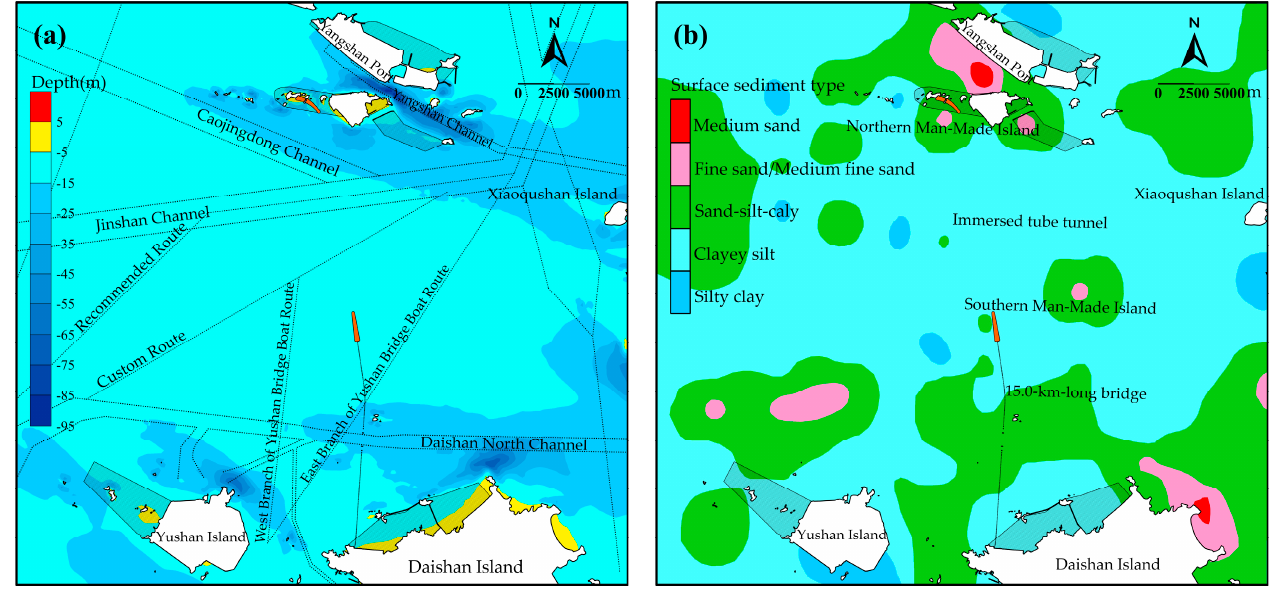
Figure 2. Distribution of present navigation channels and seabed sediment pa tt erns of the studied site. ( a ) locations of present channels; ( b ) seabed sediment pa tt erns.